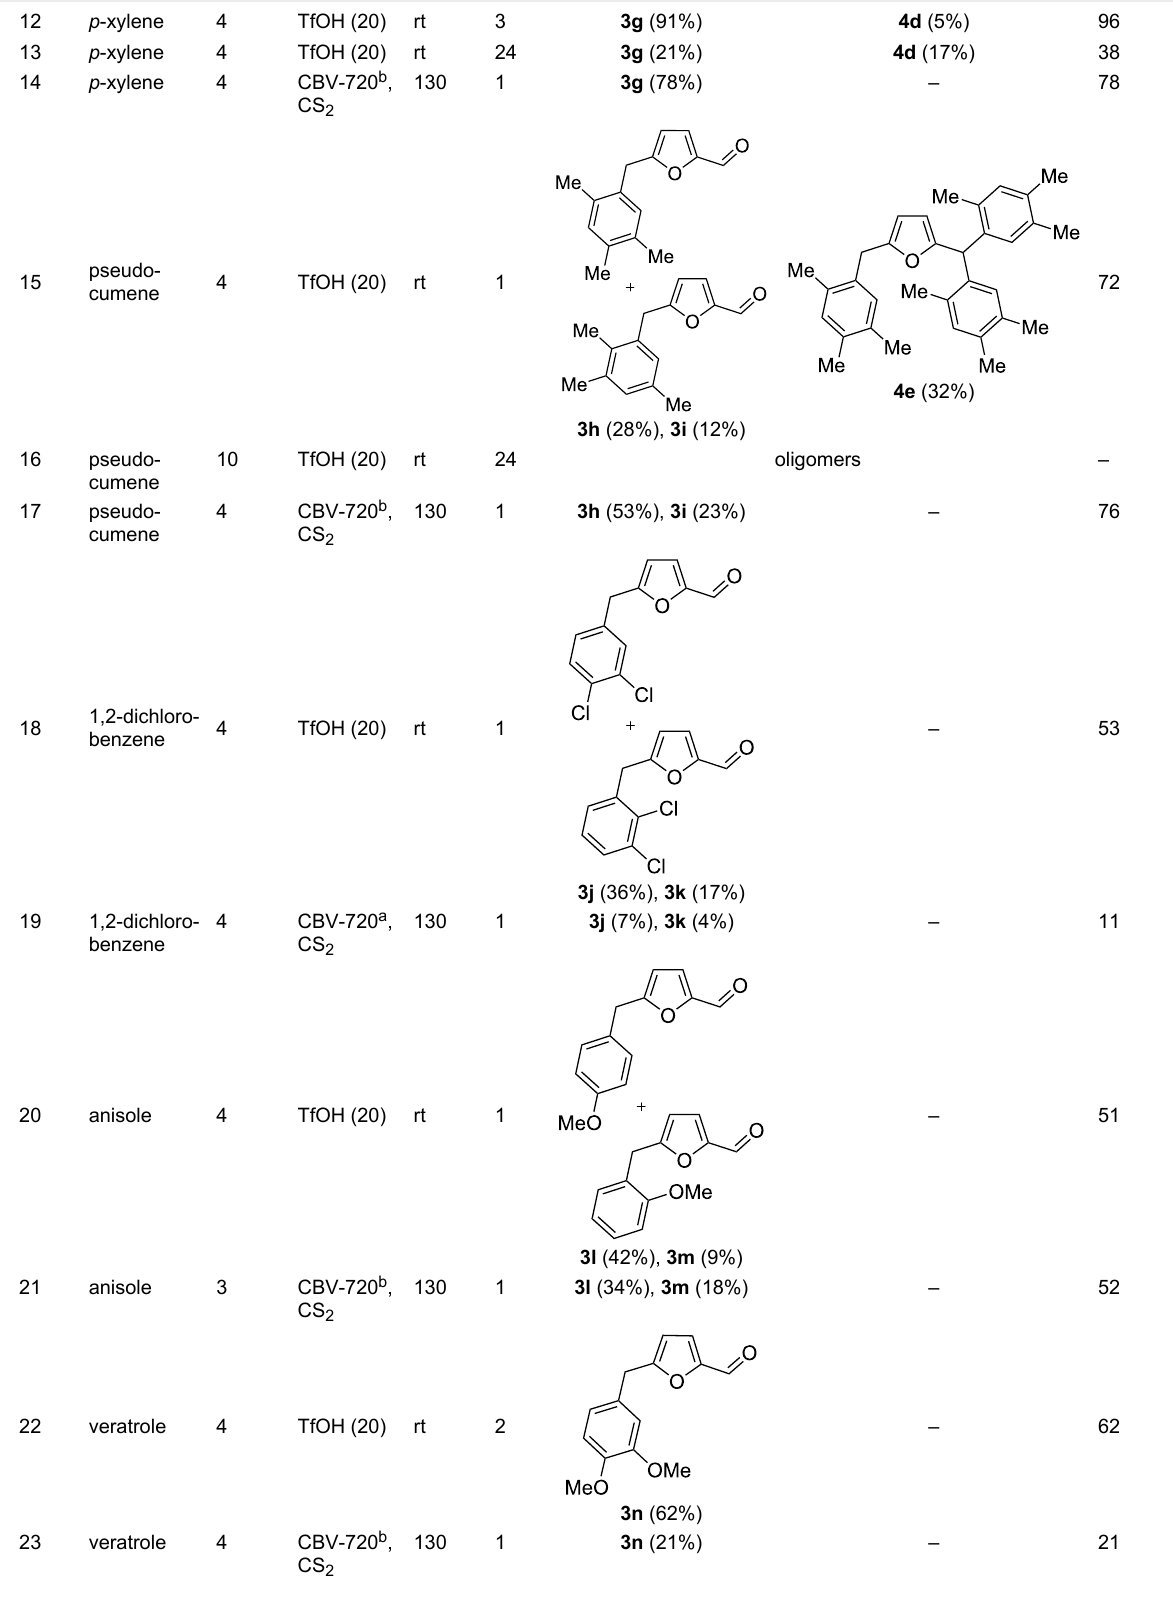
Table 4: Reactions of 5-HMF ( 1a ) with arenes under the action of TfOH or acidic zeolite CBV-720.